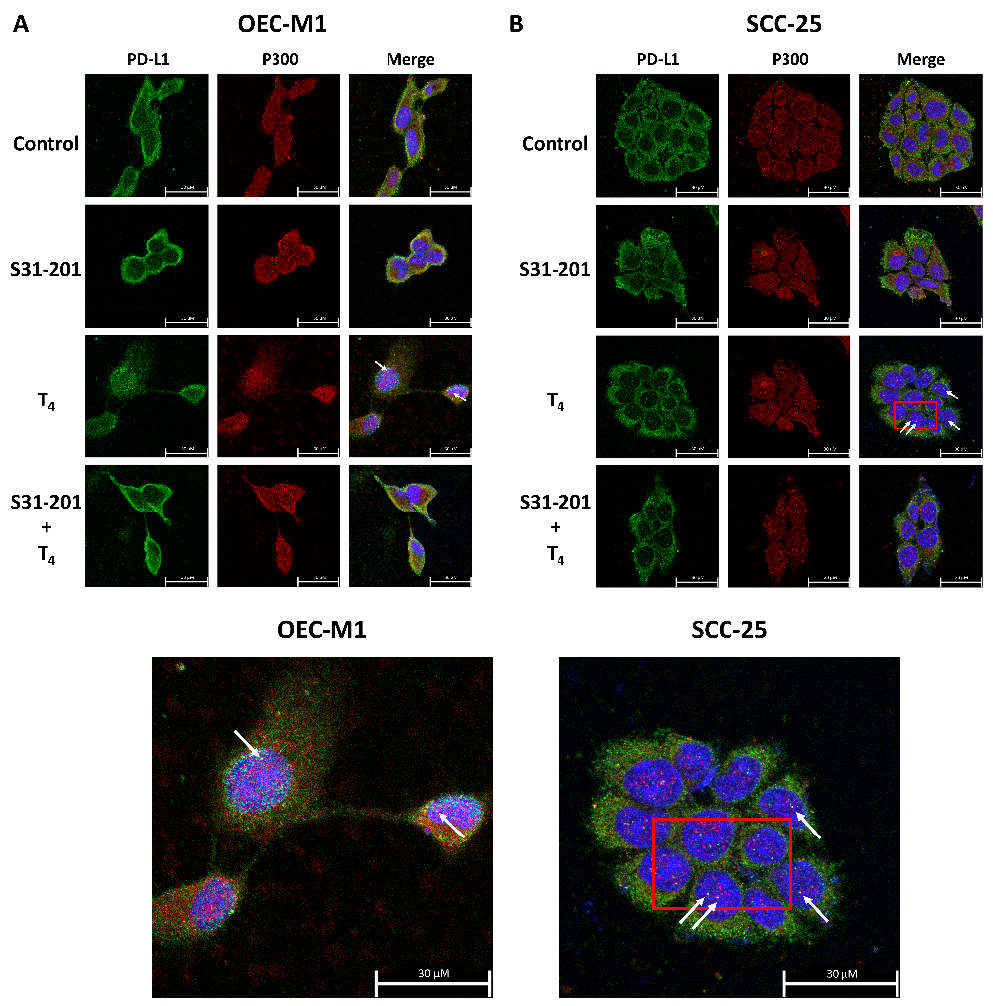
Figure 5. Thyroxine (T 4 )-induced PD-L1 complexes with nuclear proteins. Oral cancer ( A ) OEC- M1 cells and ( B ) SCC-25 cells were seeded on a cover glass. Cells were starved for 48 h, fed hormone-stripped serum-containing medium, and then treated with T 4 in the presence and absence of 40 µM S31-201 for another 24 h. Cells were fixed for confocal microscopic analysis of PD-L1 accumulation (green color) or P300 (red color). Nuclei were counterstained with DAPI (blue color). Red square is PD-L1 and P300 co-accumulation (white arrow.). Confocal microscopy was conducted as described.